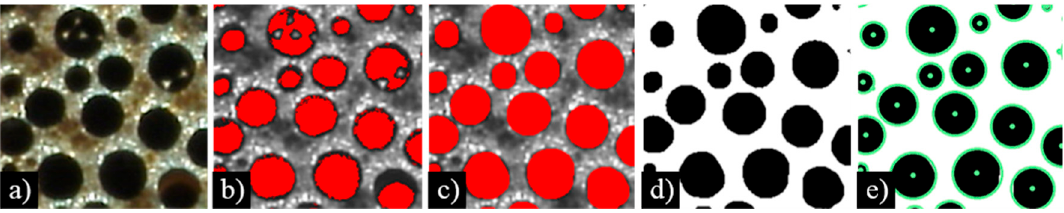
Figure 2. The acquisition of the specimen’s cross-section morphology data: ( a ) imported colour cross-section image. ( b ) Grayscale conversion and colour threshold. ( c ) Adjustment of image and grayscale threshold. ( d ) Conversion to black and white image and ( e ) pore recognition [12].